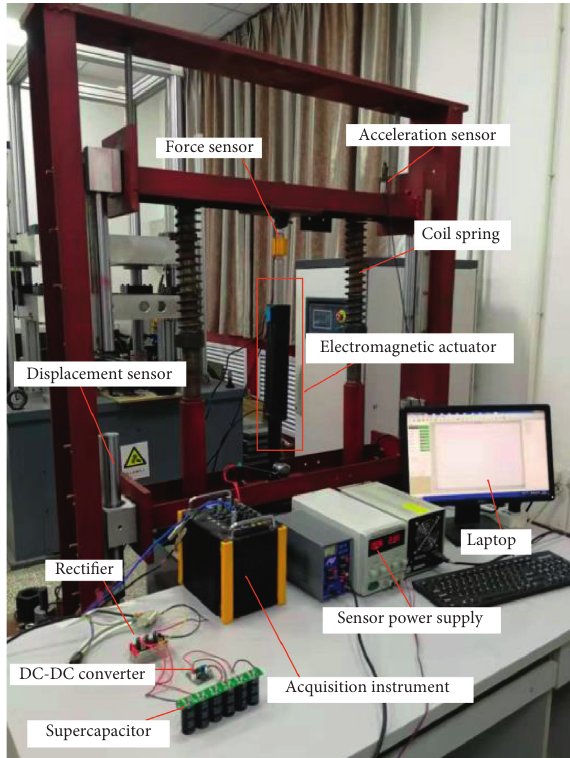
Figure 16: Energy feedback characteristic test of the actuator.